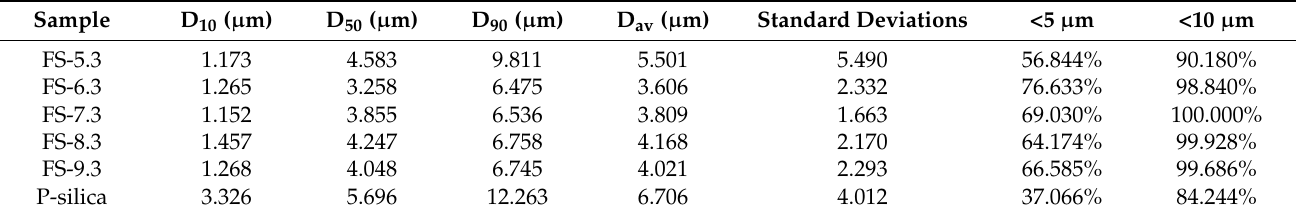
Table 2. Particle size characteristics (D 10 , D 50 , D 90 , and D av ) and the proportion of particles sized less than 5 µ m and 10 µ m of P-silica and FS-SiO 2 .